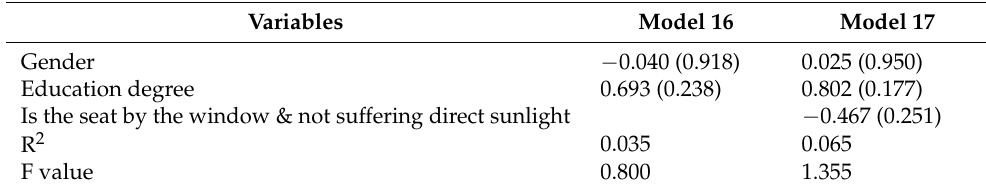
Table 7. Post hoc analysis on unit2 with “Learning efficiency” as the dependent variable (N = 280).